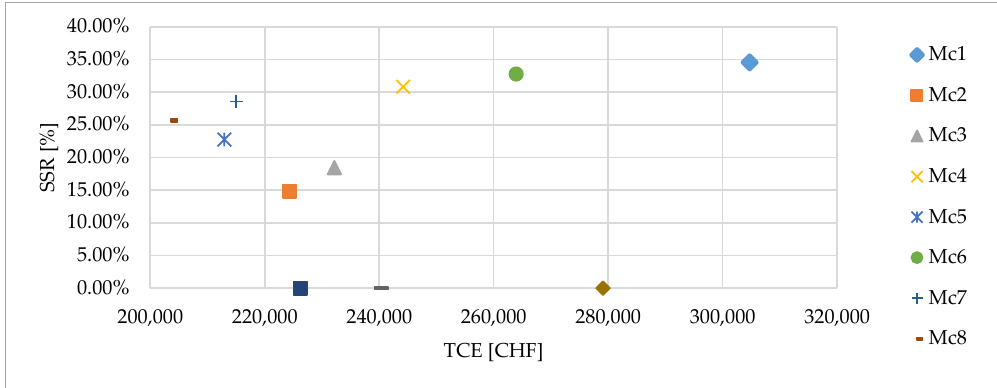
Figure 8. Correlation between self-sufficiency rate ( SSR ) and TCE of each MC .